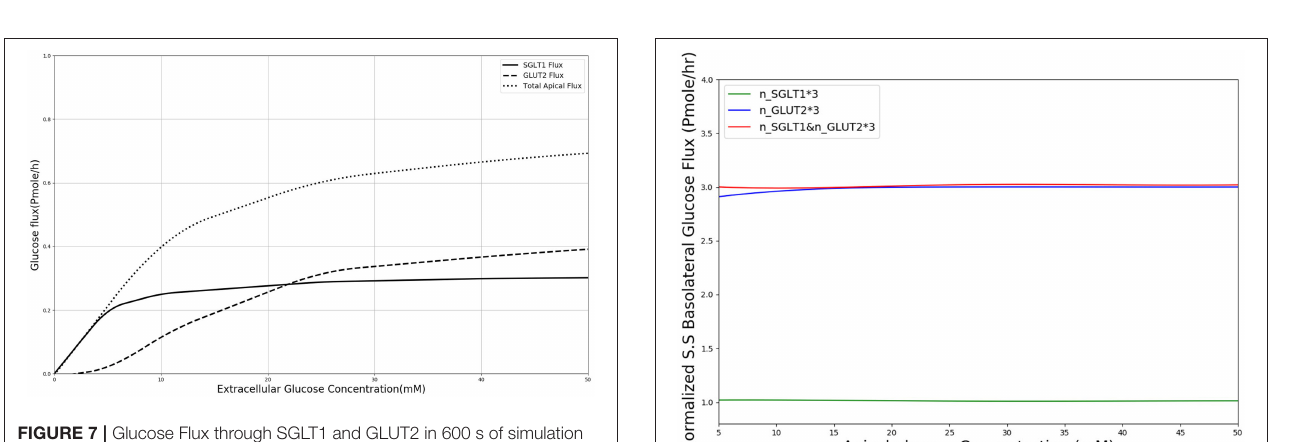
FIGURE 7 | Glucose Flux through SGLT1 and GLUT2 in 600 s of simulation along with total apical flux of glucose. deal of information for ohmic models provided by Fong et al.